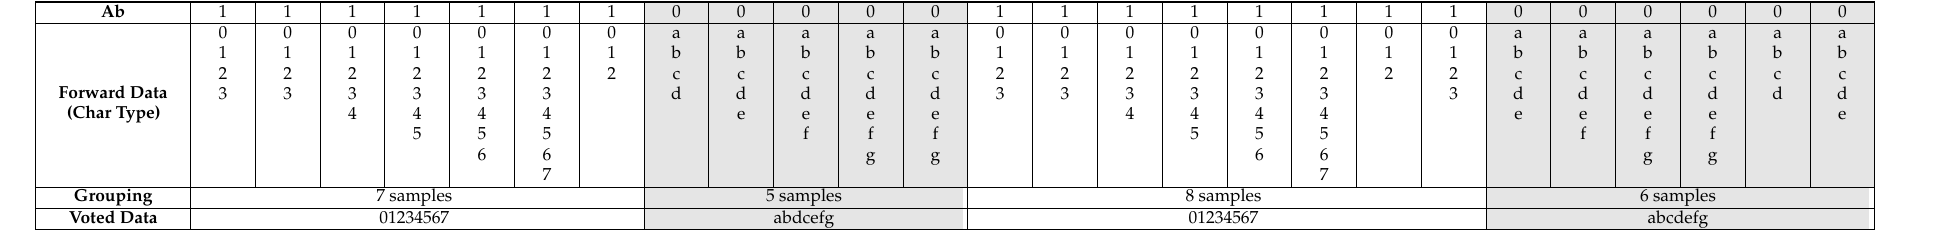
Table 7. An experiment of grouping incomplete data parts and voting (packet rate = 5